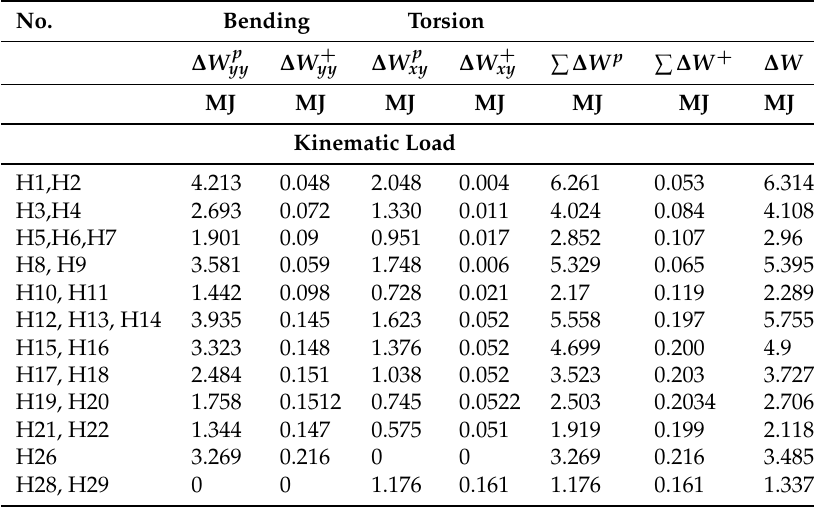
Table 4. The elastic–plastic strain energy per